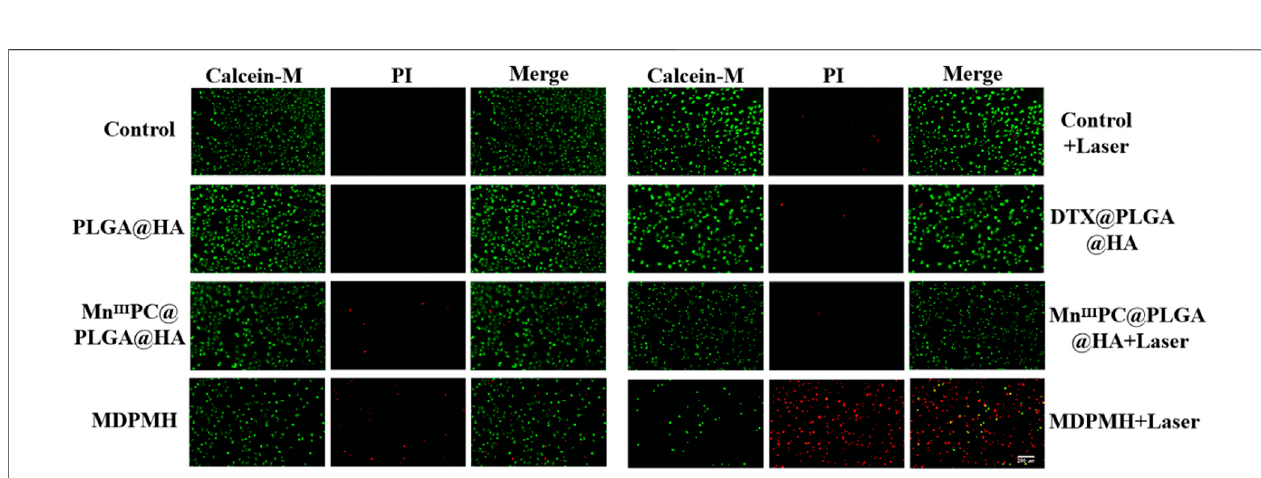
FIGURE 7 | A549 cells stained with calcein-AM under different conditions; live imaging was observed by a fl uorescence microscope. Scale bars = 50 µm.